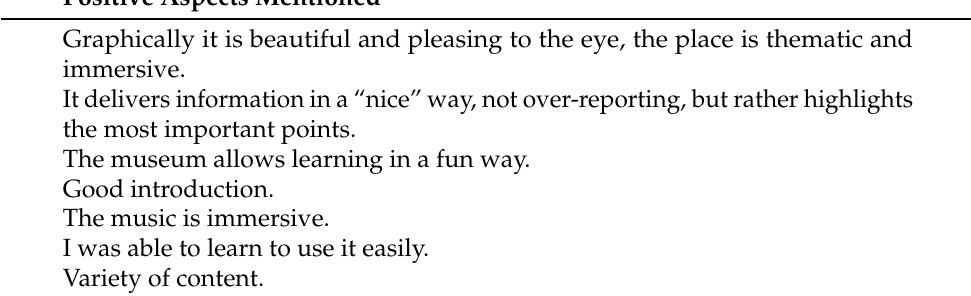
Table 4. Summary of the most relevant positive aspects found in the study. Once again, although more comments were gathered, a selection of eight was made because they highlight different aspects of the virtual reality (VR)